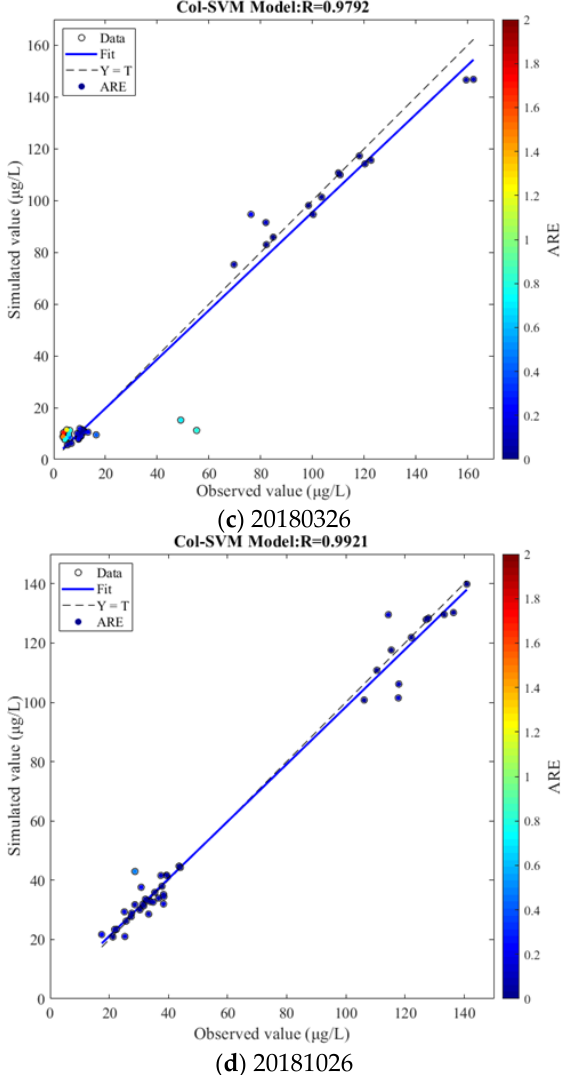
Figure 5. The simulation results at four different times.